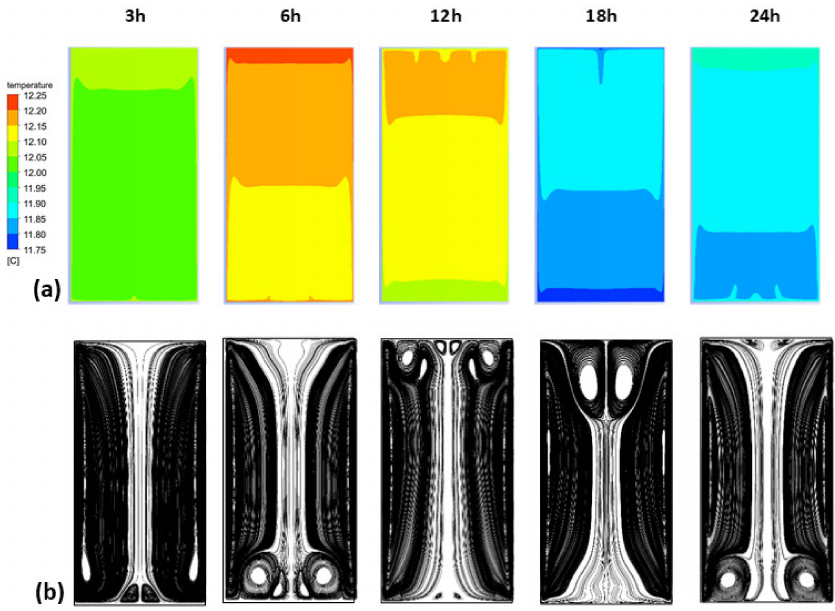
Figure 7. Evolution of the temperature of the wine over a 24 h cycle ( a ), and corresponding streamline patterns ( b